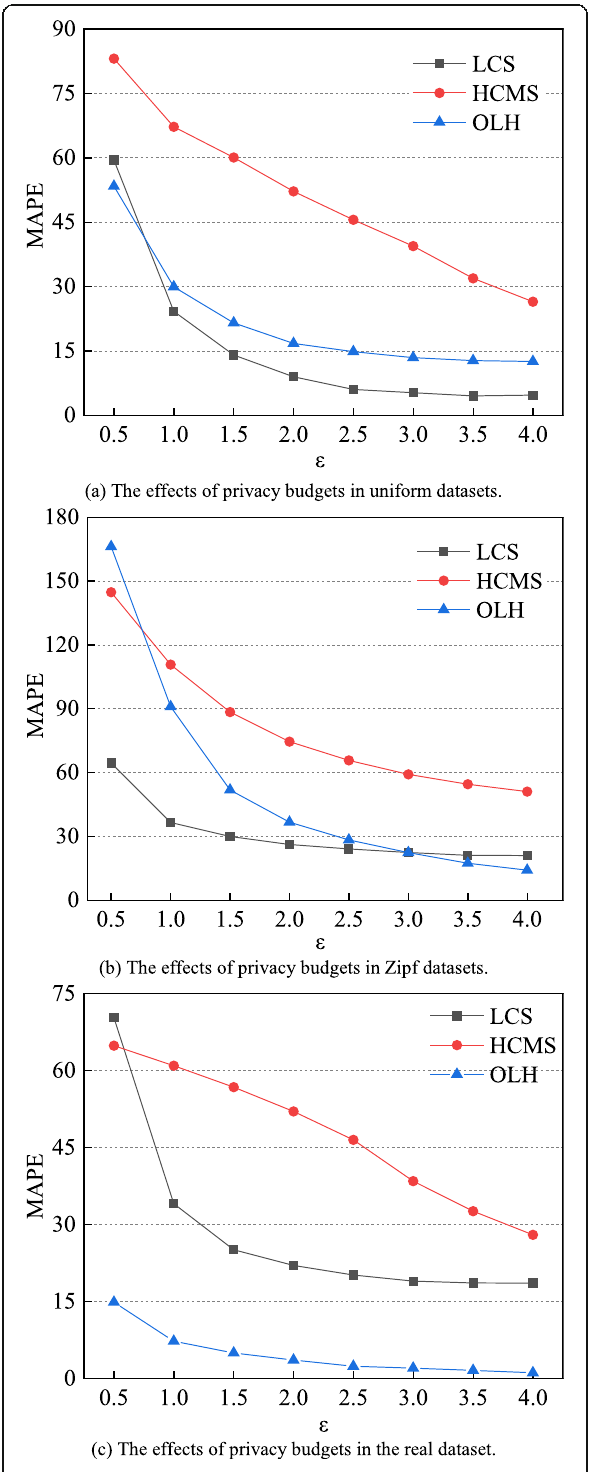
Fig. 3 The effects of privacy budgets on MAPE. a The effects of privacy budgets in uniform datasets. b The effects of privacy budgets in Zipf datasets. c The effects of privacy budgets in the real